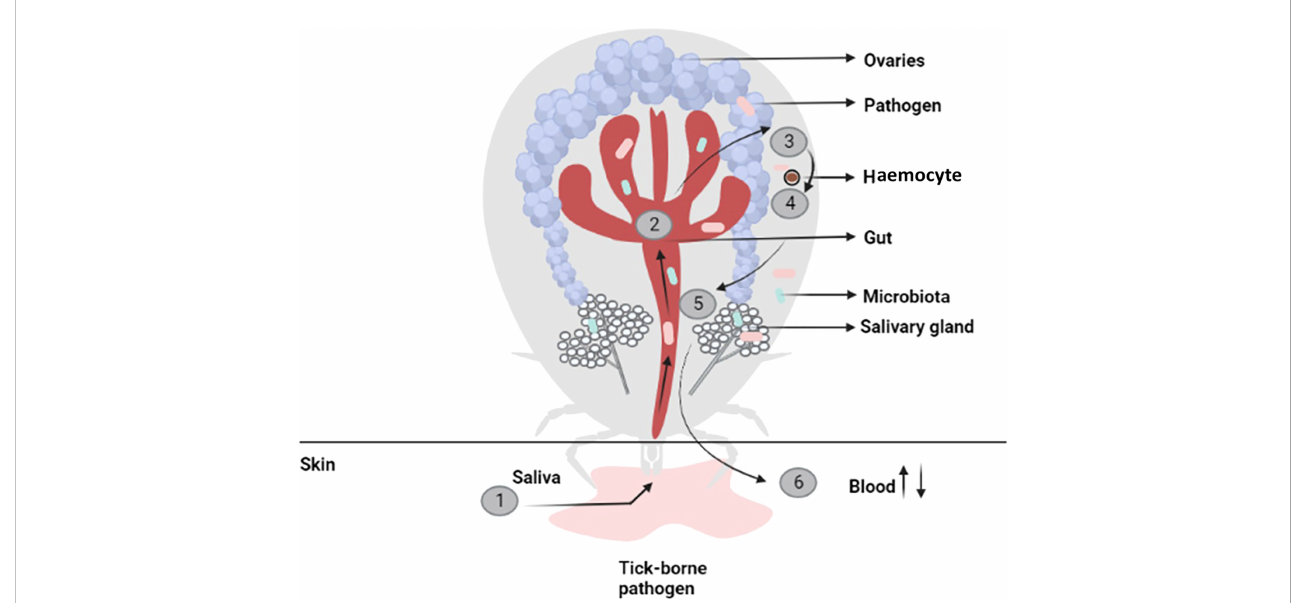
FIGURE 4 Acquisition, development, and transmission of pathogens by ticks. 1. When ticks bite, pathogens are ingested with the meal. 2. Pathogens either stay until the next meal or move through the gastrointestinal epithelium 3. The extraneous pathogen can potentially harm the tick ’ s body, depending on the type of pathogen. 4. Pathogens enter the salivary gland and attack the acini through the epithelium. 5,6. Pathogens, along with saliva, are introduced into a new host during feeding, disrupting host homeostasis and setting off in fl ammatory